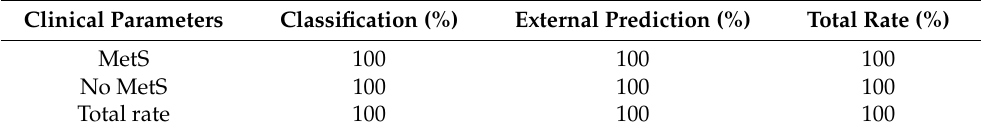
Table 3. Results of SELECT LDA classification performance on 20 IR selected spectral variables. Table 2. Results of LDA classification performance on clinical parameters.